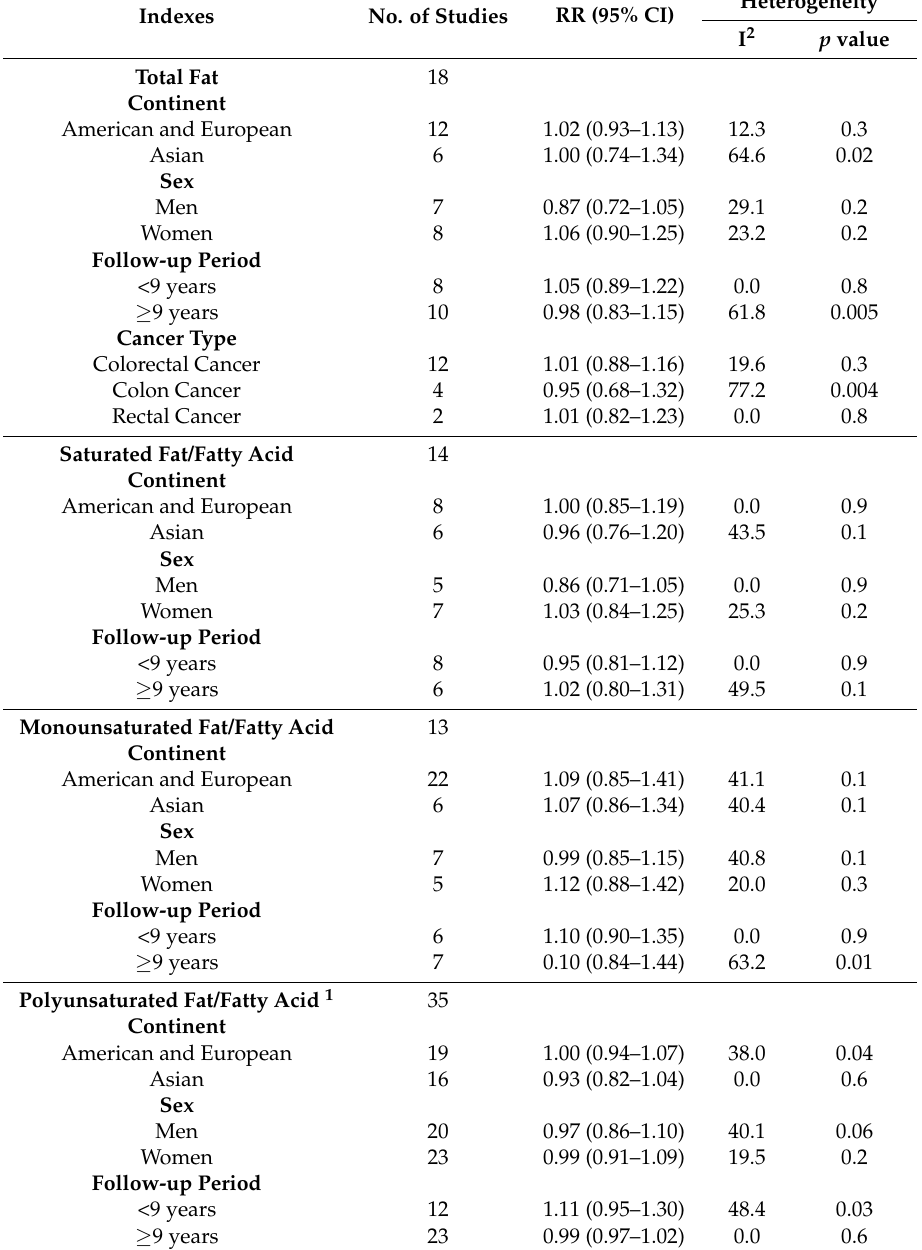
Table 1. Pooled estimates for the association between dietary fat/fatty acids and colorectal cancer risk by